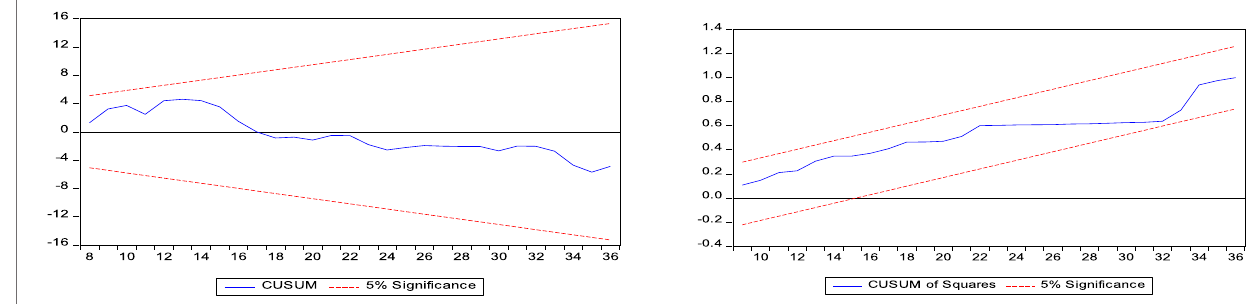
FIGURE 1 | Linear ARDL CUSUM and CUSUMSQ graphs (Morocco).